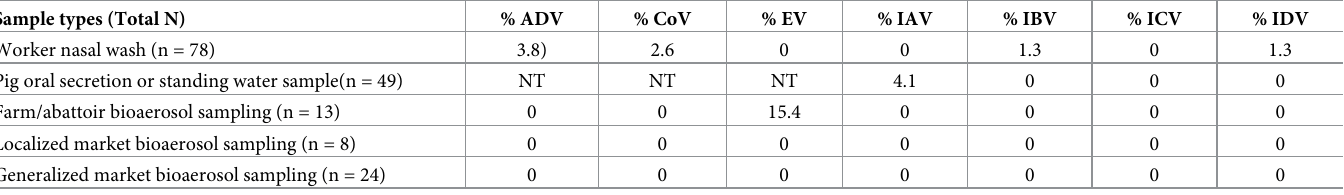
Table 2. Molecular positivity for respiratory viruses detected via rPCR or rRT-PCR in samples collected from animal environments in Sarawak, Malaysia in June and July of 2017.